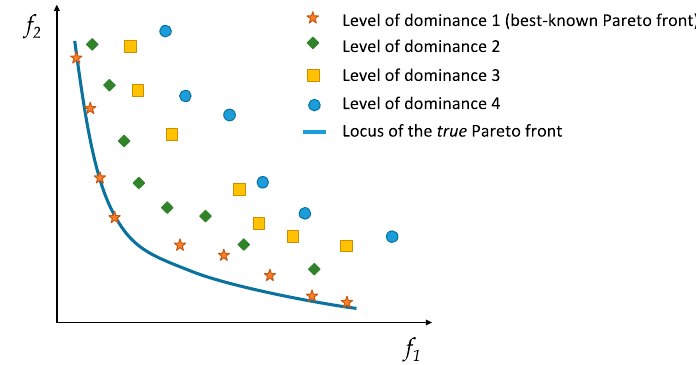
Figure 8. Levels of dominance. The functions f 1 and f 2 are minimized.